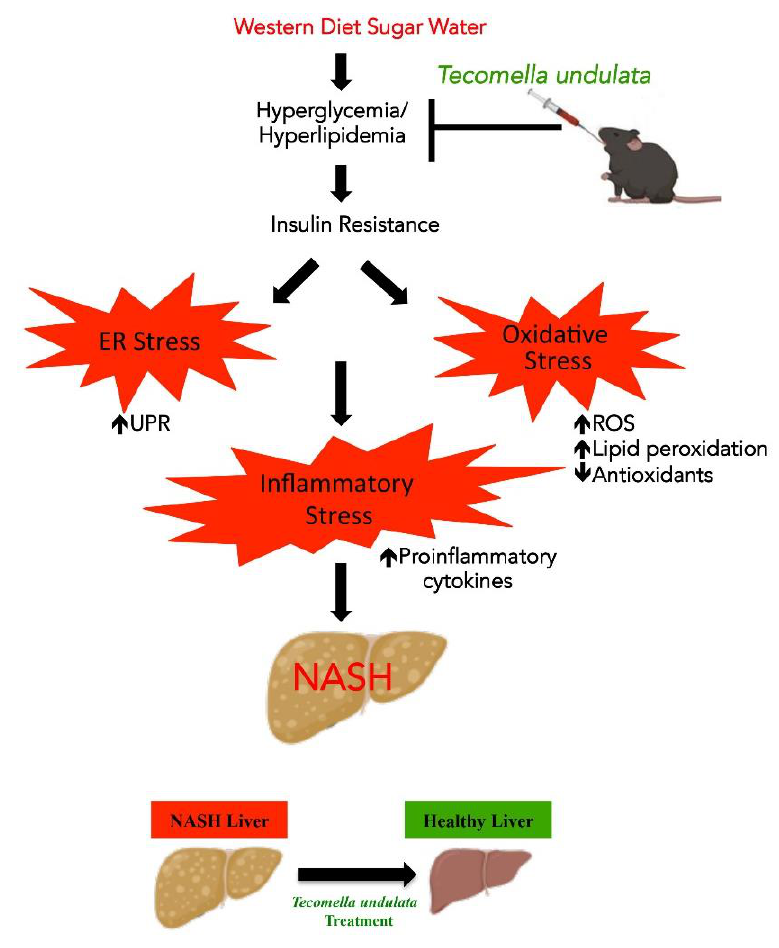
Figure 8. Schematic representation depicting the mechanisms involved in Tecomella undulata ( TU ) -mediated amelioration of NASH. Mice fed on WDSW for 12 weeks were treated with Tecomella undulata via oral gavage for another 12 weeks. Administration of Tecomella undulata ameliorated steatohepatitis in WDSW mice by improving insulin sensitivity, ER stress, oxidative stress, and in- creased production of antioxidants providing evidence that Tecomella undulata may have the potential to be used in the treatment of